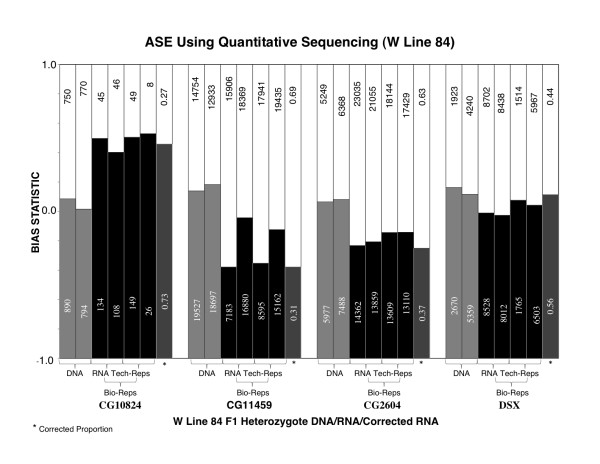
Count-based ASE assays. Allele-specific expression represented as sequencing reads per W-allele (black) and tester allele (white). The sequencing coverage per allele is shown on each bar and the corrected RNA (*) is represented as a proportion of each allele. The y-axis is the proportion of the difference (allele1- allele2)/(allele1 + allele2).